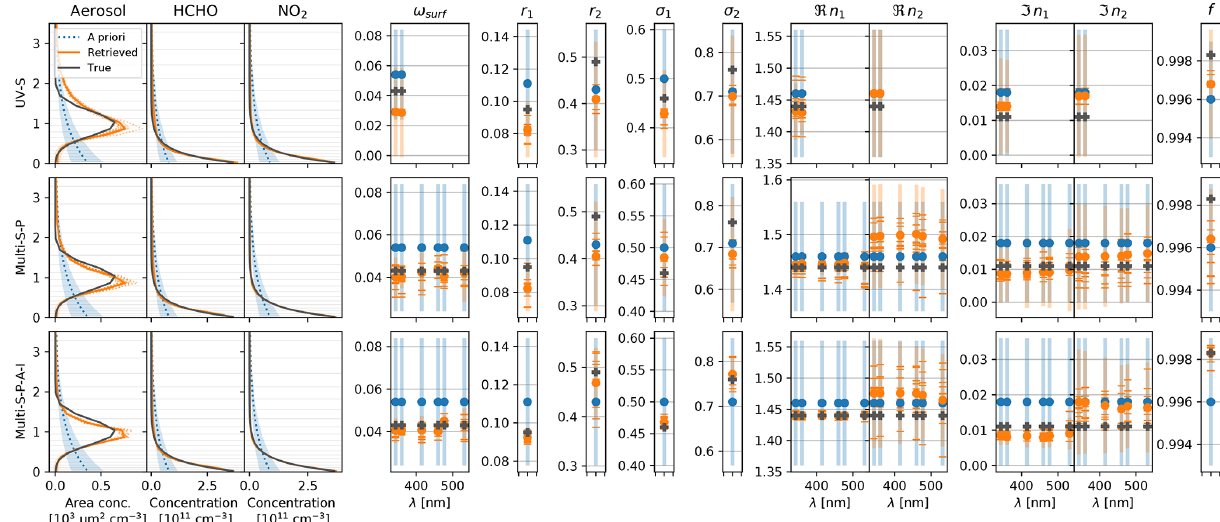
Figure 10. Retrieval results for the Aer7-TG3 scenario. Description of Fig. 9